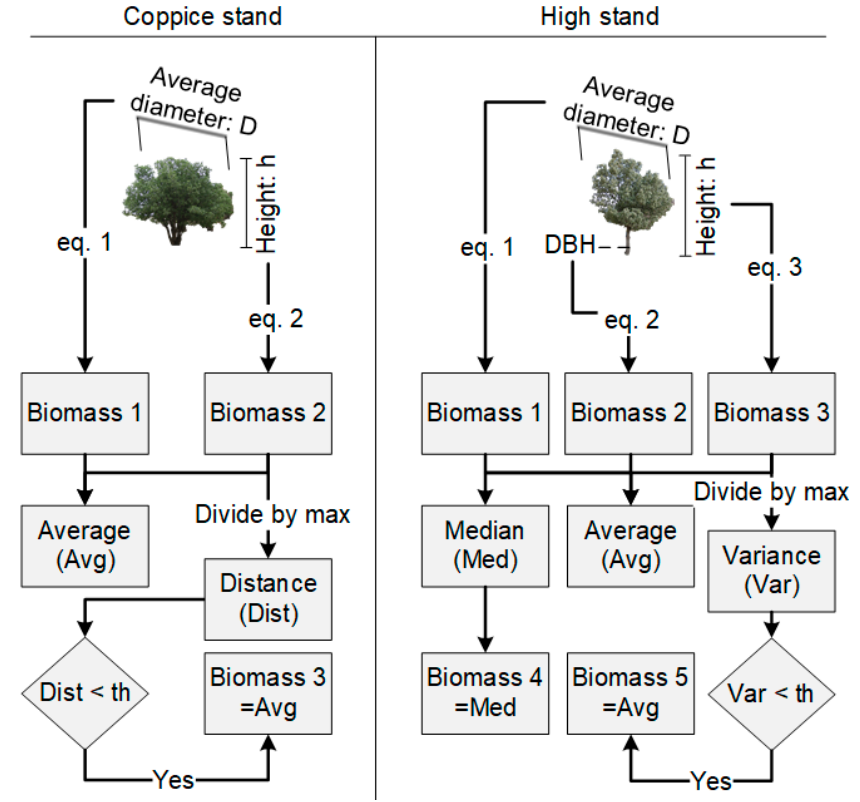
Figure 3. Flowchart of generating different AGB values.